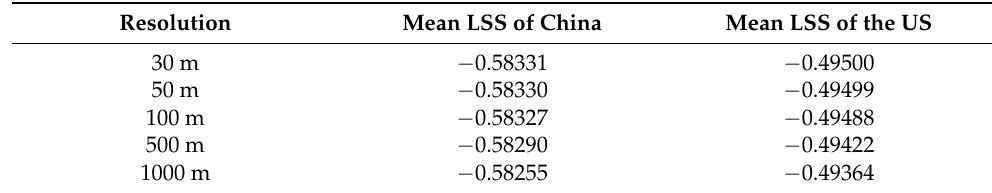
Table 2. Mean LSS for China and the Conterminous United States (abbreviated as “the US” in the table) from maps at different resolutions).